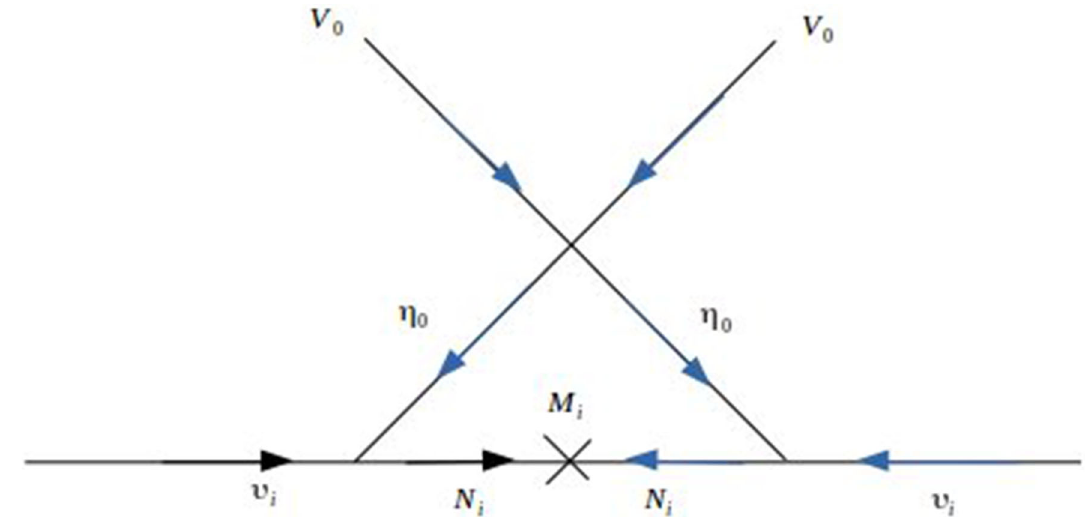
Fig. 1 Neutrino mass generation at one loop level. Where here V 0 is the VEV of SM Higgs and η 0 denoting either η R or η